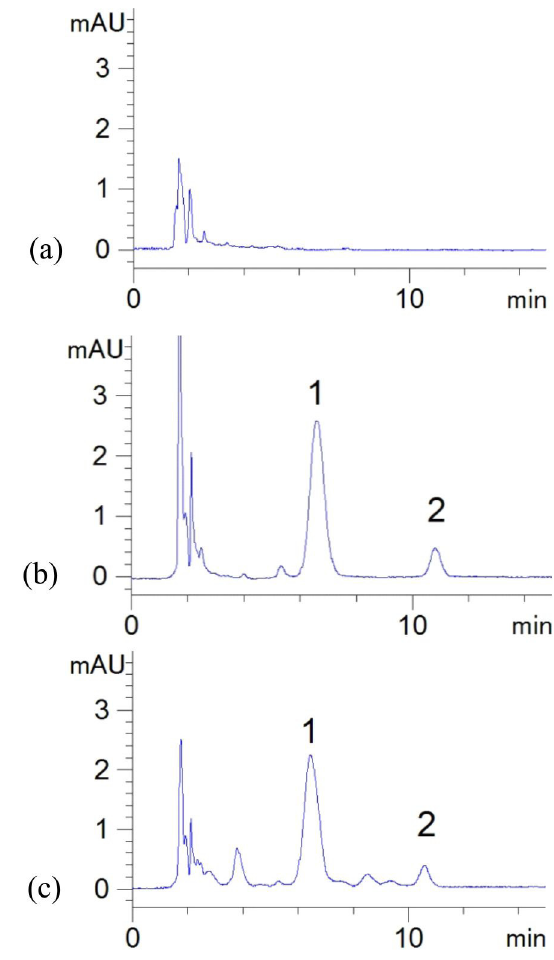
FIGURE 2 - Representative chromatograms of blank plasma (a), plasma spiked with isoquercitrin and vitexin (b) and plasma sample 60 min after the intravenous administration of isoquercitrin at a dose of 10 mg·kg -1 (c). Peak 1: vitexin; Peak 2: